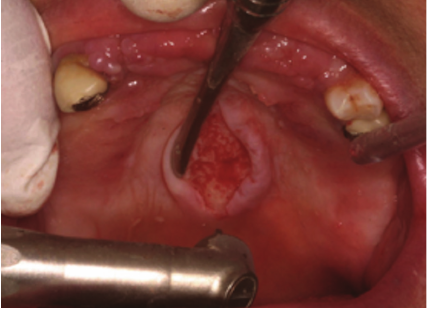
Figure 4: Photomicrograph of histological appearance of TM shows dense bony tissue, presence of lacunae and normal osteocytes (hematoxylin-eosin, original magnification 200x).